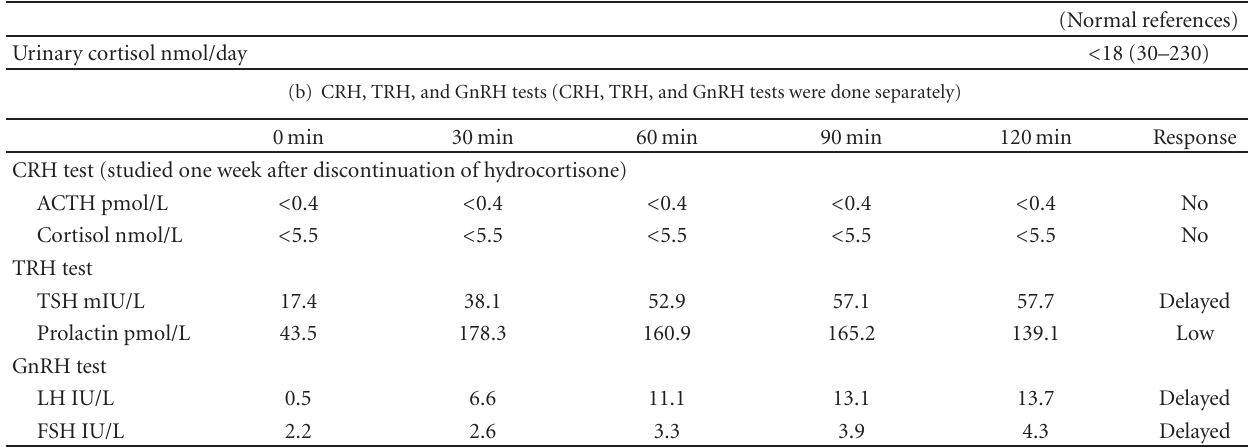
Table 3: Endocrine studies at 6 months post partum.